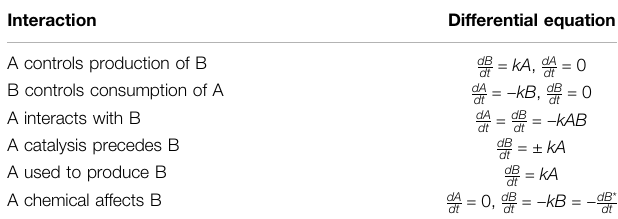
TABLE 3 | Translation of BioPAX interactions into simple ordinary differential equations. See in Figure 2 the (hyper-)graph representation of these